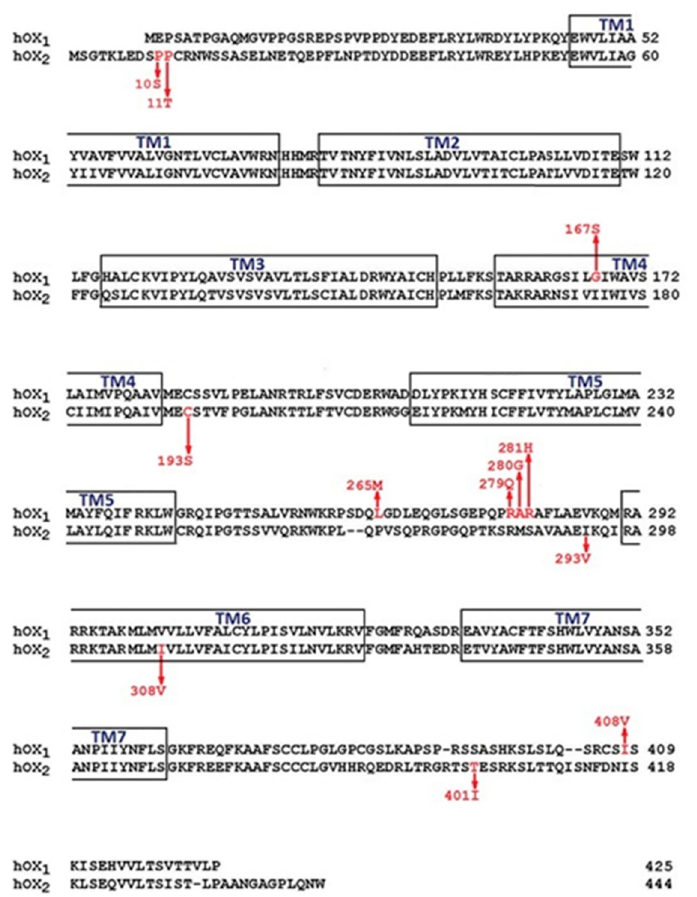
Figure 1. Alignment of the human OX 1 and OX 2 receptor amino acid sequences. The common wild-type sequence of OX 1 receptor is shown (top) and the common wild-type sequence of OX 2 is shown (bottom). Arrows mark the location of known amino acid variants in relation to transmembrane regions 1–7 (TM1–TM7). Alignment adapted from Alscript output [46].